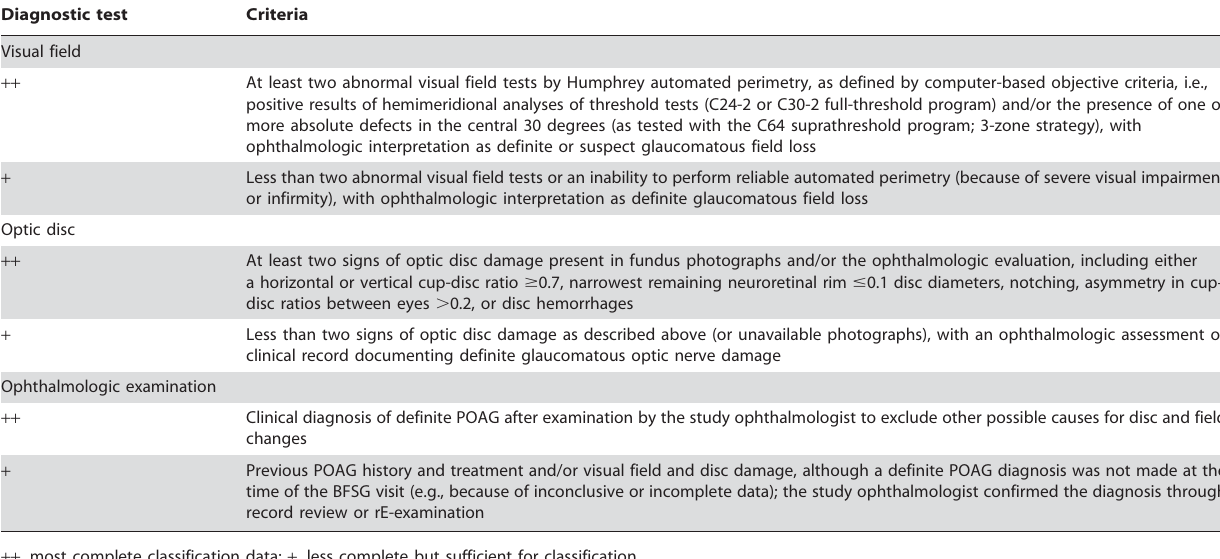
Table 1. Diagnostic criteria for POAG.